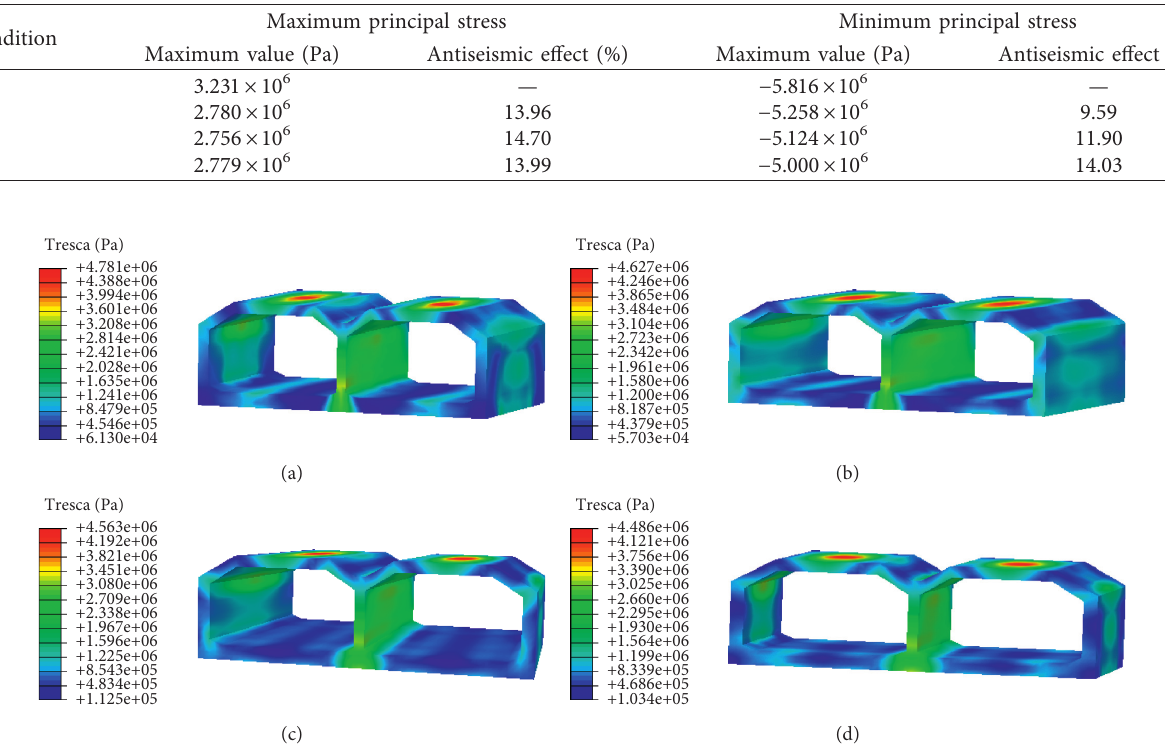
Table 4: Principal stress and antiseismic effect.